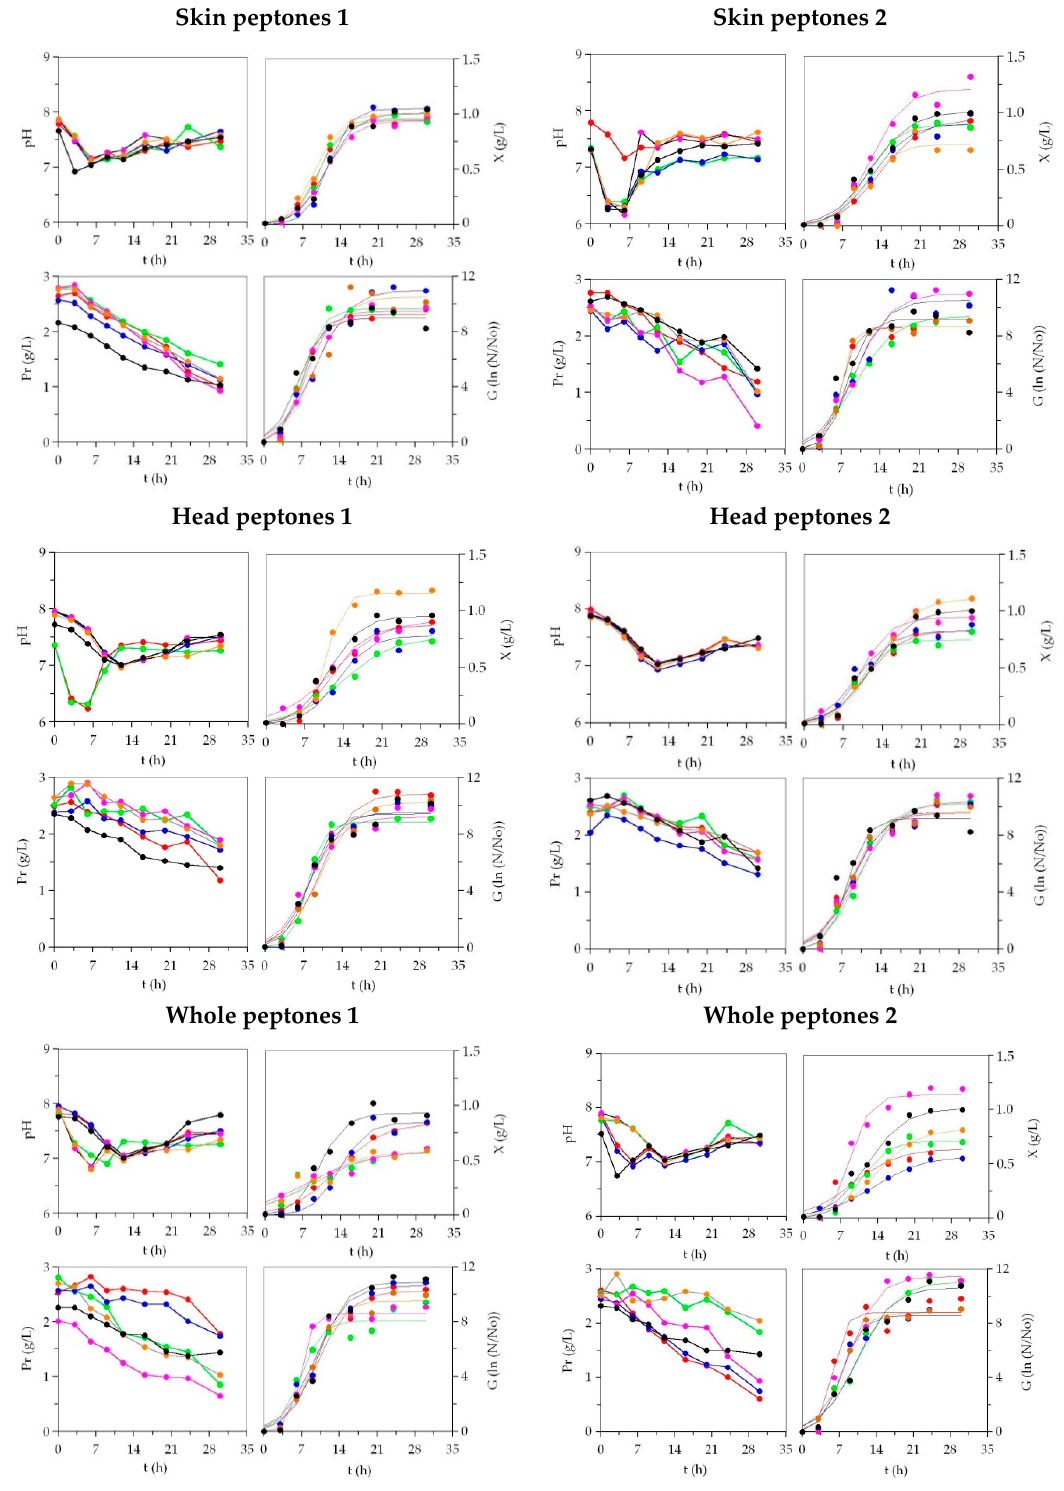
Figure 2 . Culture kinetics of Phaeobacter sp. in marine media based on marine peptones from discarded fish and by-products. Peptones 1: (cid:145) : BW; (cid:145) : RS; (cid:145) : Ma; (cid:145) : Po; (cid:145) : Gu; (cid:145) : MM1. Peptones 2: (cid:145) : Gr; (cid:145) : Me; (cid:145) : Ha; (cid:145) : Bo; (cid:145) : AHM; (cid:145) : MM2. Experimental data of biomass ( X ) and viable cells ( G ) were fitted to the logistic equation. Protein (Pr) uptakes and pH are also shown. The confidence intervals of the experimental data (for two replicates) were in all cases less than 20% of the experimental mean values and omitted for clarity.